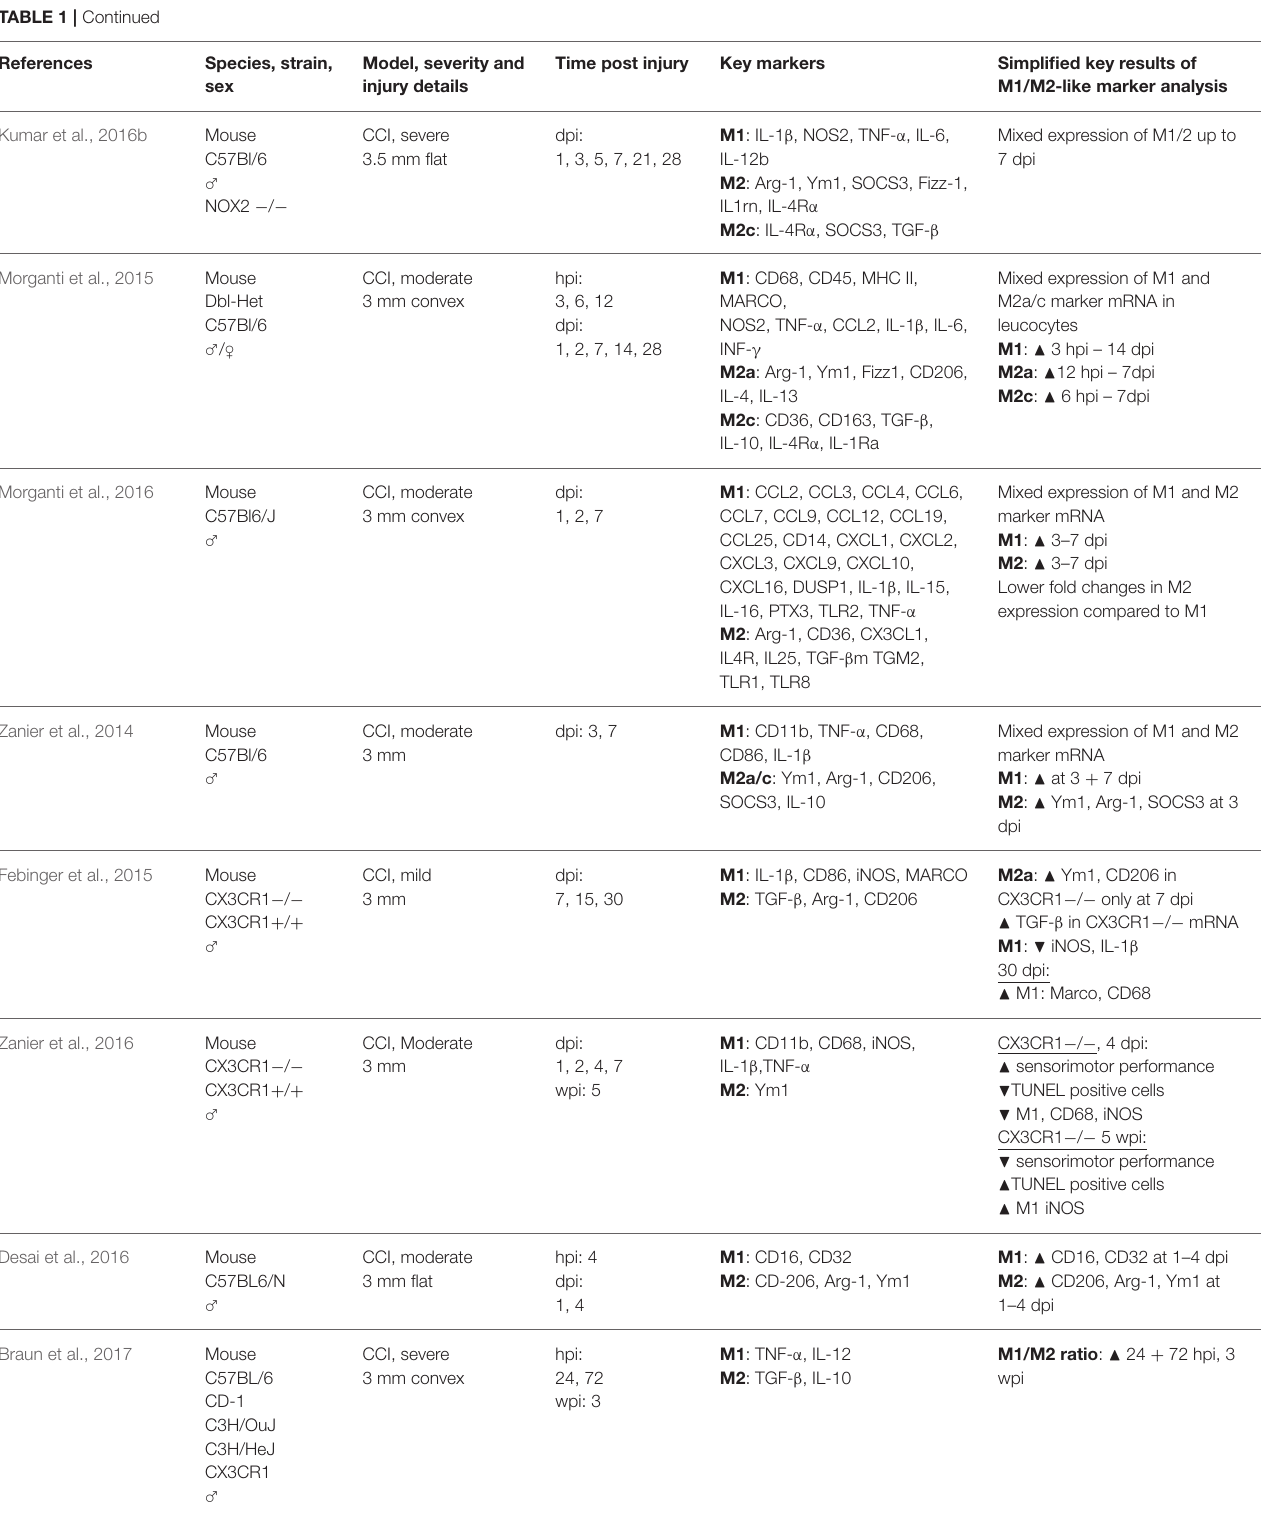
Key markers Simplified key results of M1/M2-like marker